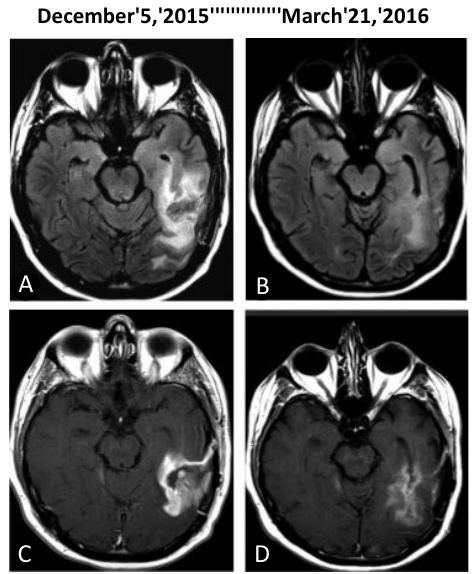
Figure 3. Effect of KD concomitant with inhalational POH in a patient with recurrent GB. Representative brain MRI scans are shown from before the onset of treatment (left panels) and after 3 months of treatment (right panels). ( A , B ) MRI axial fluid-attenuated inversion recovery (FLAIR); ( C , D ) T1-weighted image (T1W) with contrast. Note marked reduction of peritumoral edema and tumor size after treatment.